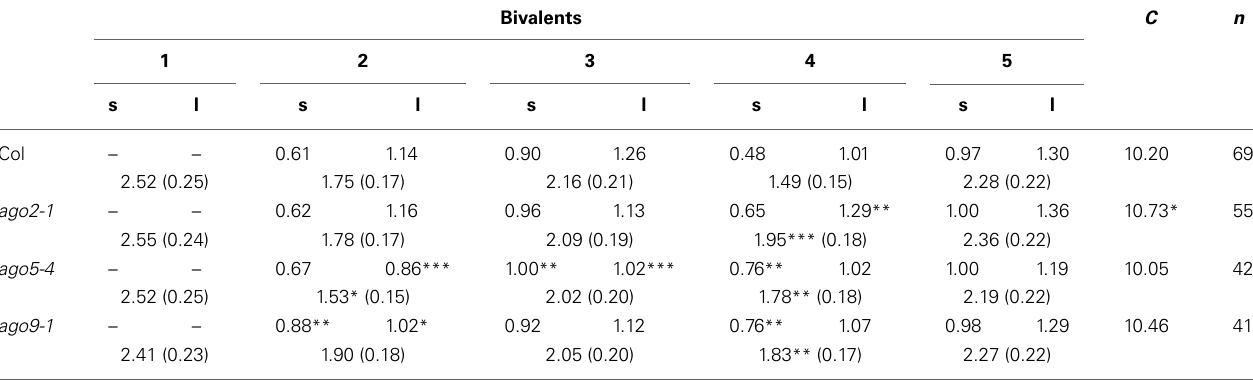
Table 1 | Mean chiasma frequencies per cell, per bivalent and per bivalent arm (short vs. long) in the Col accession, ago2-1, ago5-4, and ago9-1 . Bivalents C n 3 4